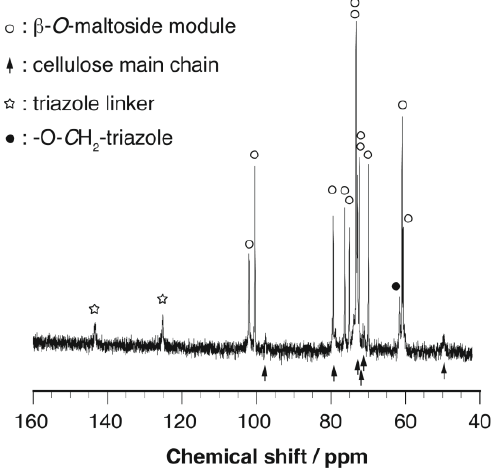
Figure 4. 13 C NMR spectrum of Cel- O -Mal, in which open circles, arrows, open stars, and a closed circle indicate main peaks assignable to the  - O -maltoside modules, the cellulose main chain, the triazole linkers, and methylene spacers (–O– C H 300 MHz, DMSO- d , 60 6